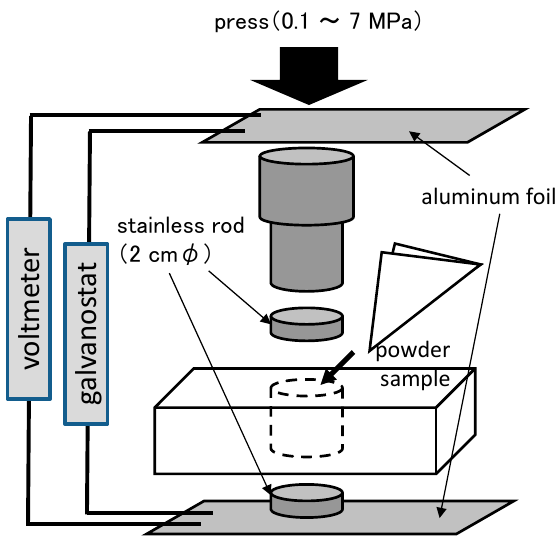
Figure 18. Schematic diagram of a compression cell for measuring conductivity of powder samples.